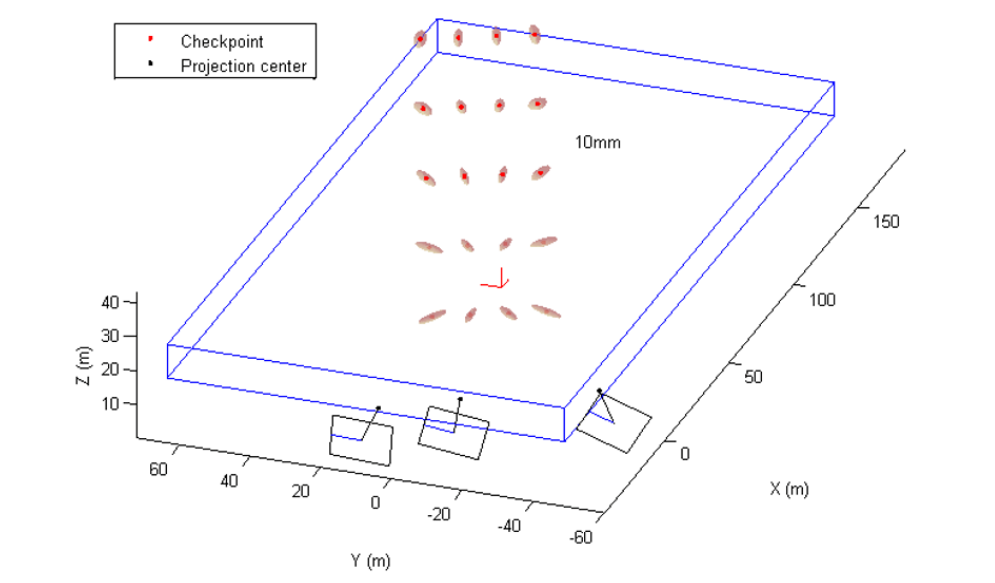
Figure 2. The a priori estimated error ellipsoids of some representative signalized points attached below of the bridge body